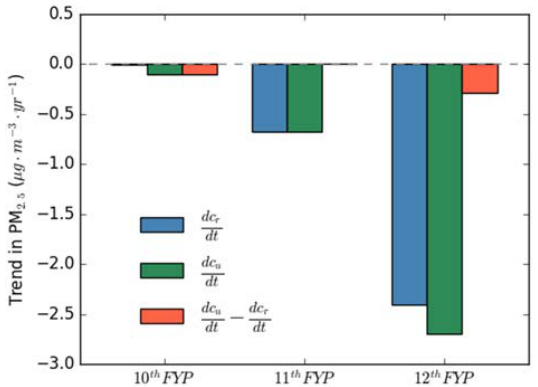
Figure 6. Averages of PM 2.5 trends in rural ( dc r / dt ) and urban ( dc u / dt ) areas (blue and green bars, respectively) across the entire study region during the three FYP periods. The red bars represent the difference in the averaged PM 2.5 trends between rural and urban areas ( D = dc u / dt − dc r / dt ) during the three FYP periods.